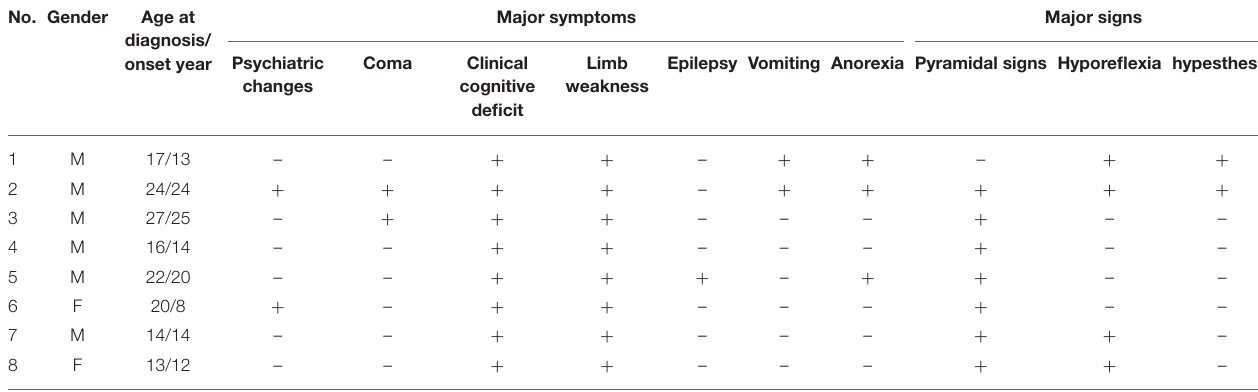
TABLE 1 | Clinical manifestations in 8 late-onset cblC